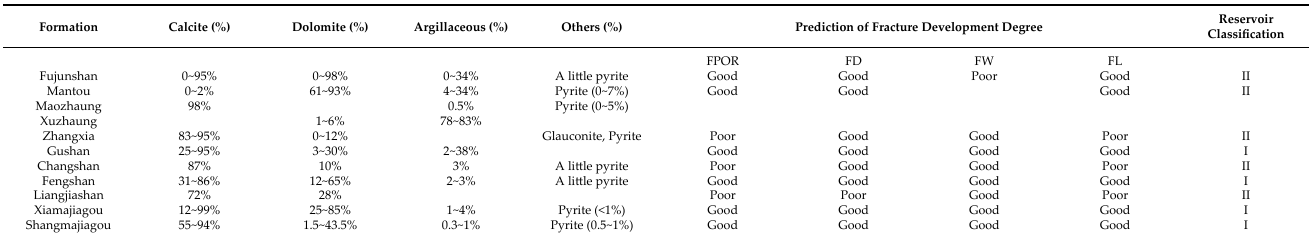
Table 4. Prediction of fracture development degree based on the MLP model of mineral composition in geological